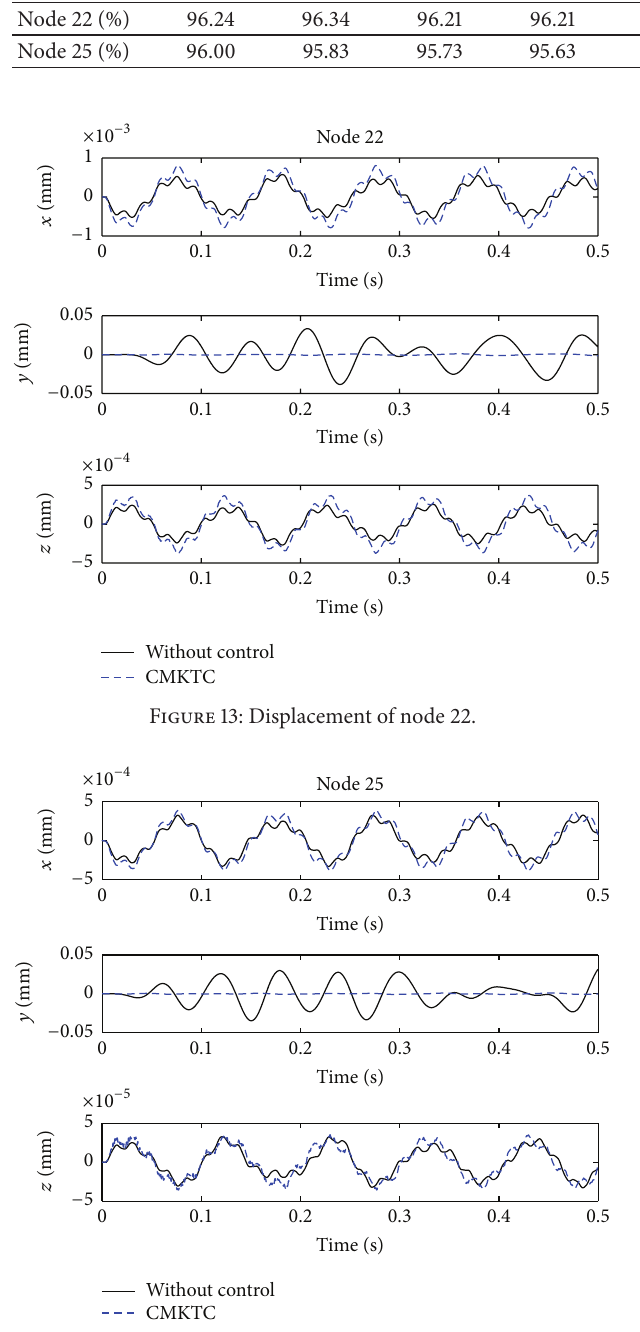
Figure 14: Displacement of node 25.